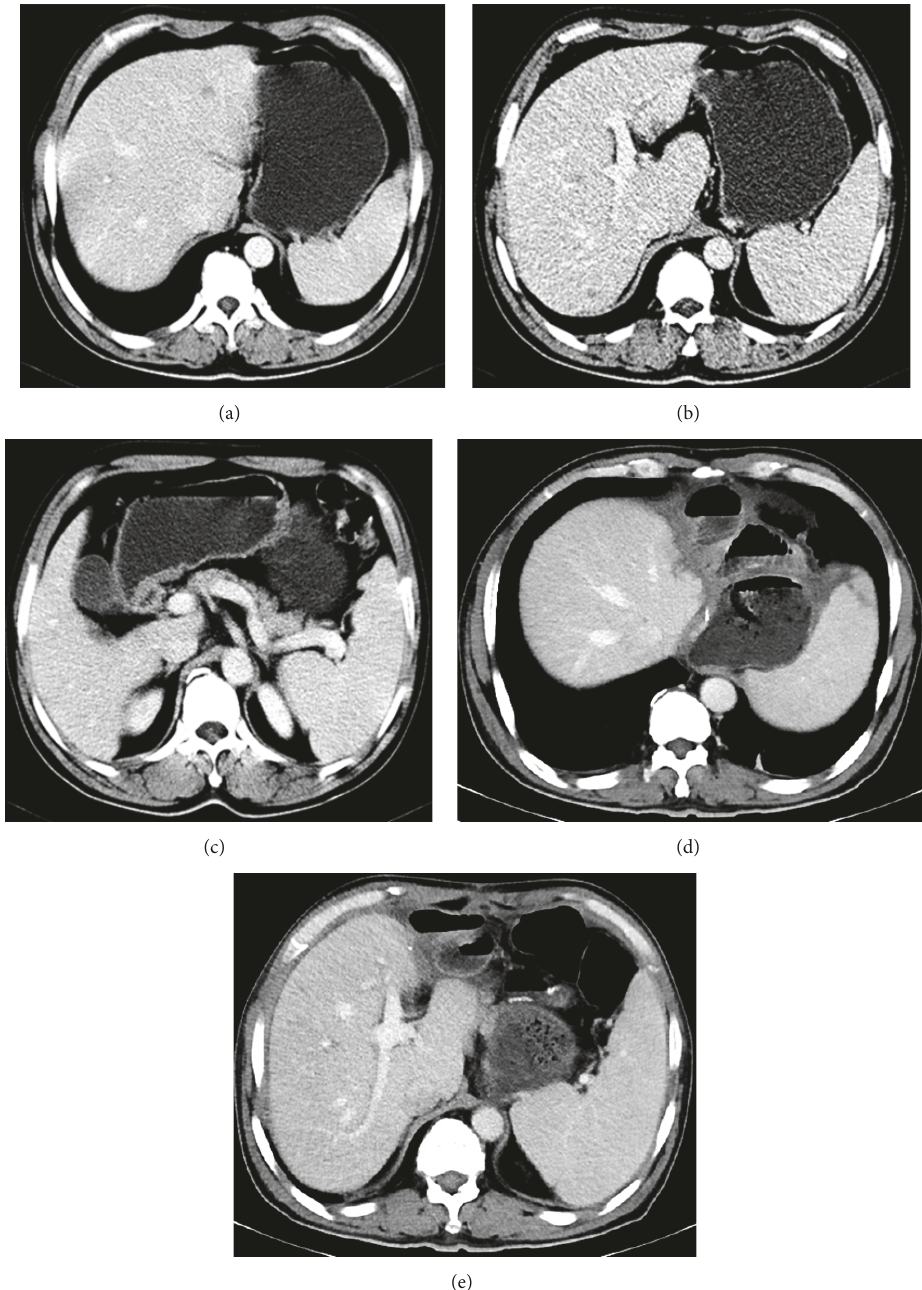
Figure 5: Follow-up abdominal computed tomography scans after six of EOX chemotherapy (a, b, c) and 27 months after surgery (d, e) . (a) The liver metastatic nodules in liver segment 4 that had been previously observed have almost disappeared; (b) the liver metastatic lesion in the left lobe of liver that had been previously observed has evidently been reduced; (c) the gastric mass has almost disappeared; (d) postradical distal gastrectomy with Roux-en-Y with residual stomach and jejunum anastomosis and D2 lymphadenectomy combined with liver metastatic lesions resection, with no evidence of tumor recurrence 27 months after surgery; (e) no recurrence of metastatic lesions after 27